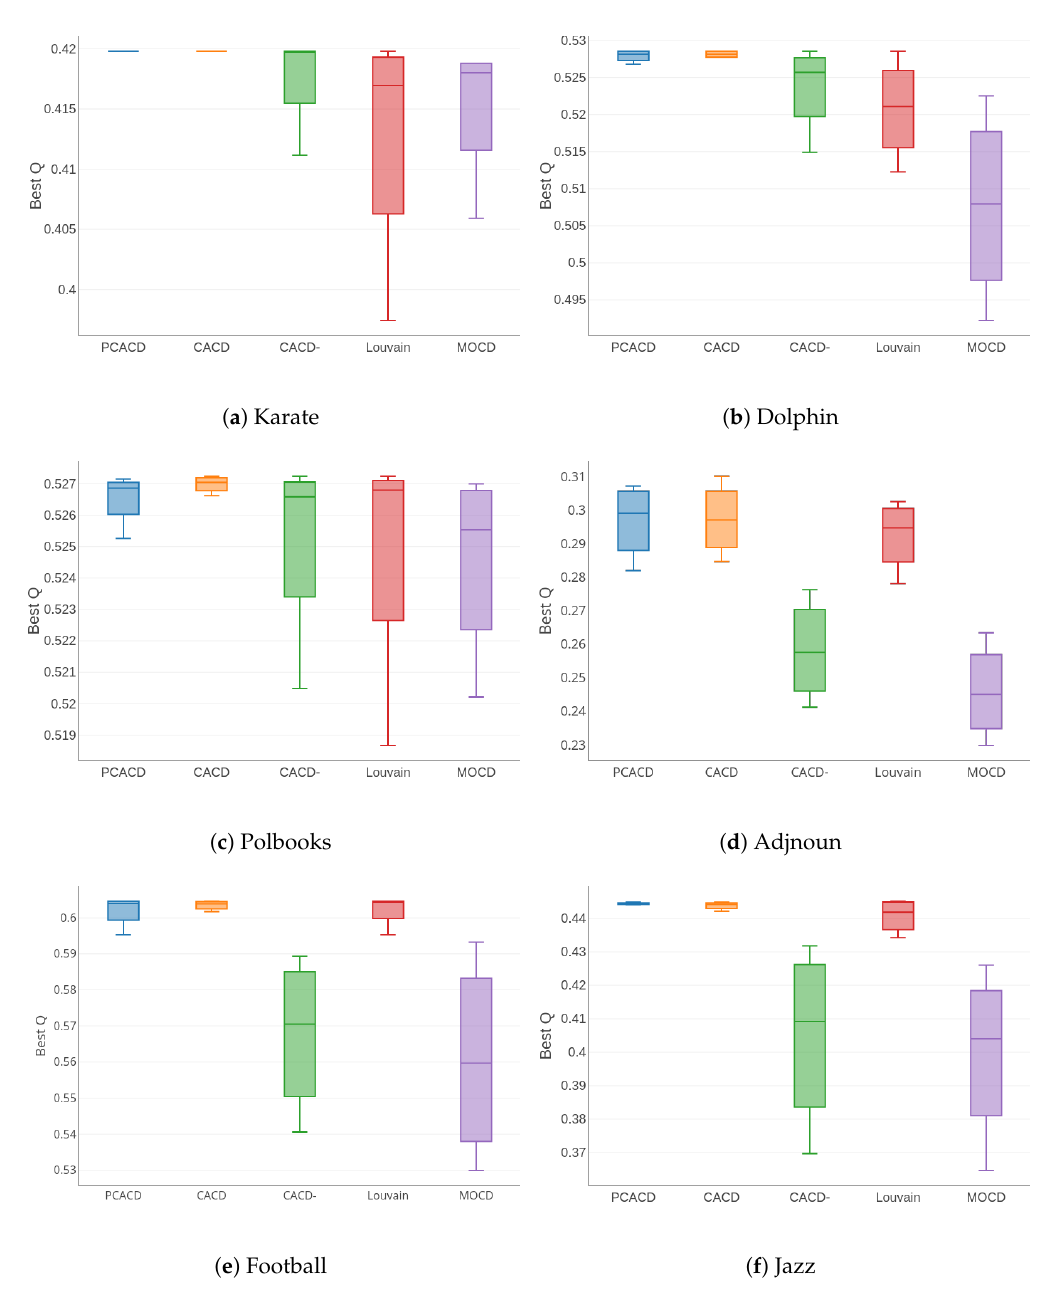
Figure 3. The box plots of the best modularity ( Q ) scores over 30 runs of each of the five algorithms for all six real-world networks (PCACD: parallel conical area community detection algorithm; CACD: conical area community detection algorithm; CACD-: conical area community detection algorithm variant without the local search strategy; MOCD: multi-objective community detection